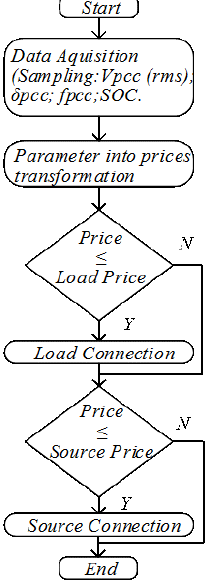
Figure 11. Implemented DSC code